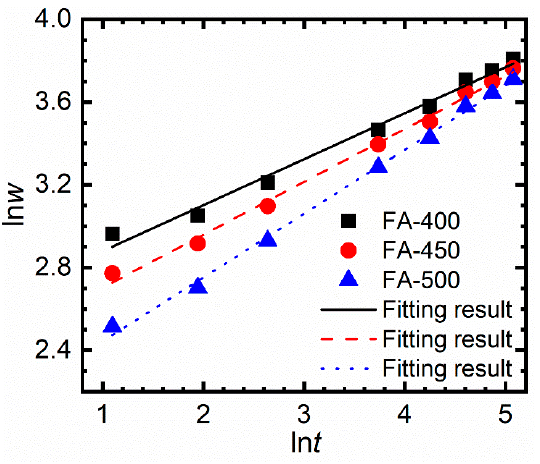
Figure 7. Fitting results of the corrosion kinetics for FA-400, FA-450, and FA-500. Table 1. Results of ln k , n , and k by using the data of weight gain for the three samples. Constant